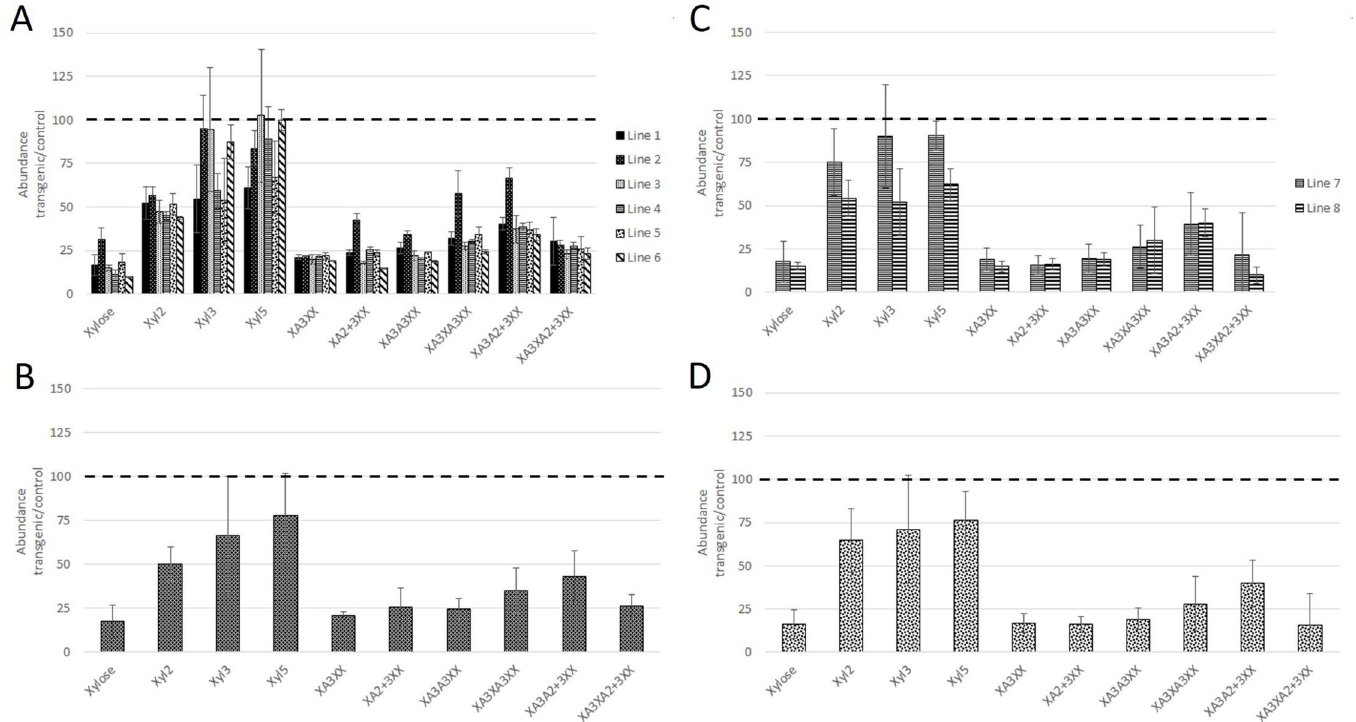
Fig 1. Relative abundances (transgenics compared to controls) of oligosaccharides (AXOS) released by digestion of arabinoxylan (AX) in wheat flour with endoxylanase and separation by High Performance Anion Exchange Chromatography (HPAEC). A, lines T1-6 (GT43_1 RNAi) compared with respective null controls N1-6; B lines T7 and T8 (GT43_1+GT43_2+GT47_2- triple RNAi) compared individually with the means of lines C1-3; C, means of lines T1-6 compared with means of lines N1-6: D, means of lines T7 and T8 compared with means of lines C1-3.